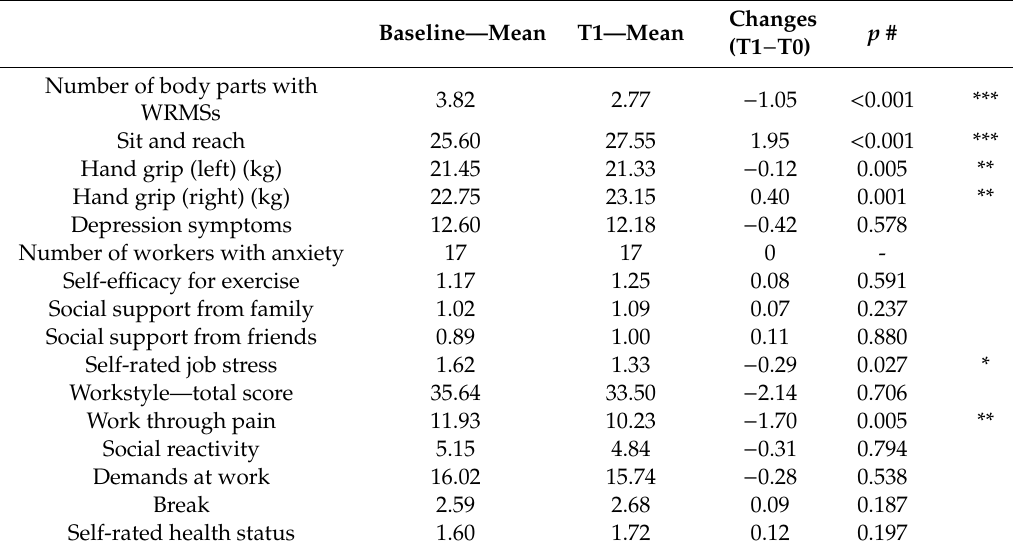
Table 4. Changes in the number of body parts with WRMSs and associated factors over time (T1 − T0).